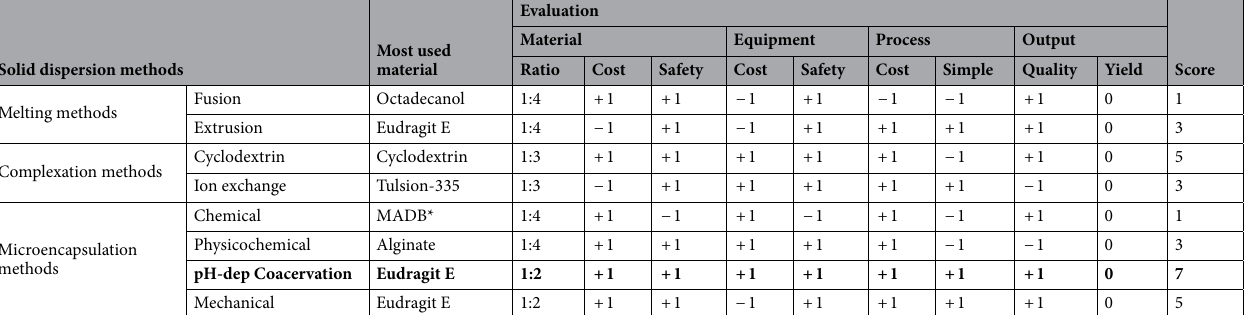
Solid dispersion methods